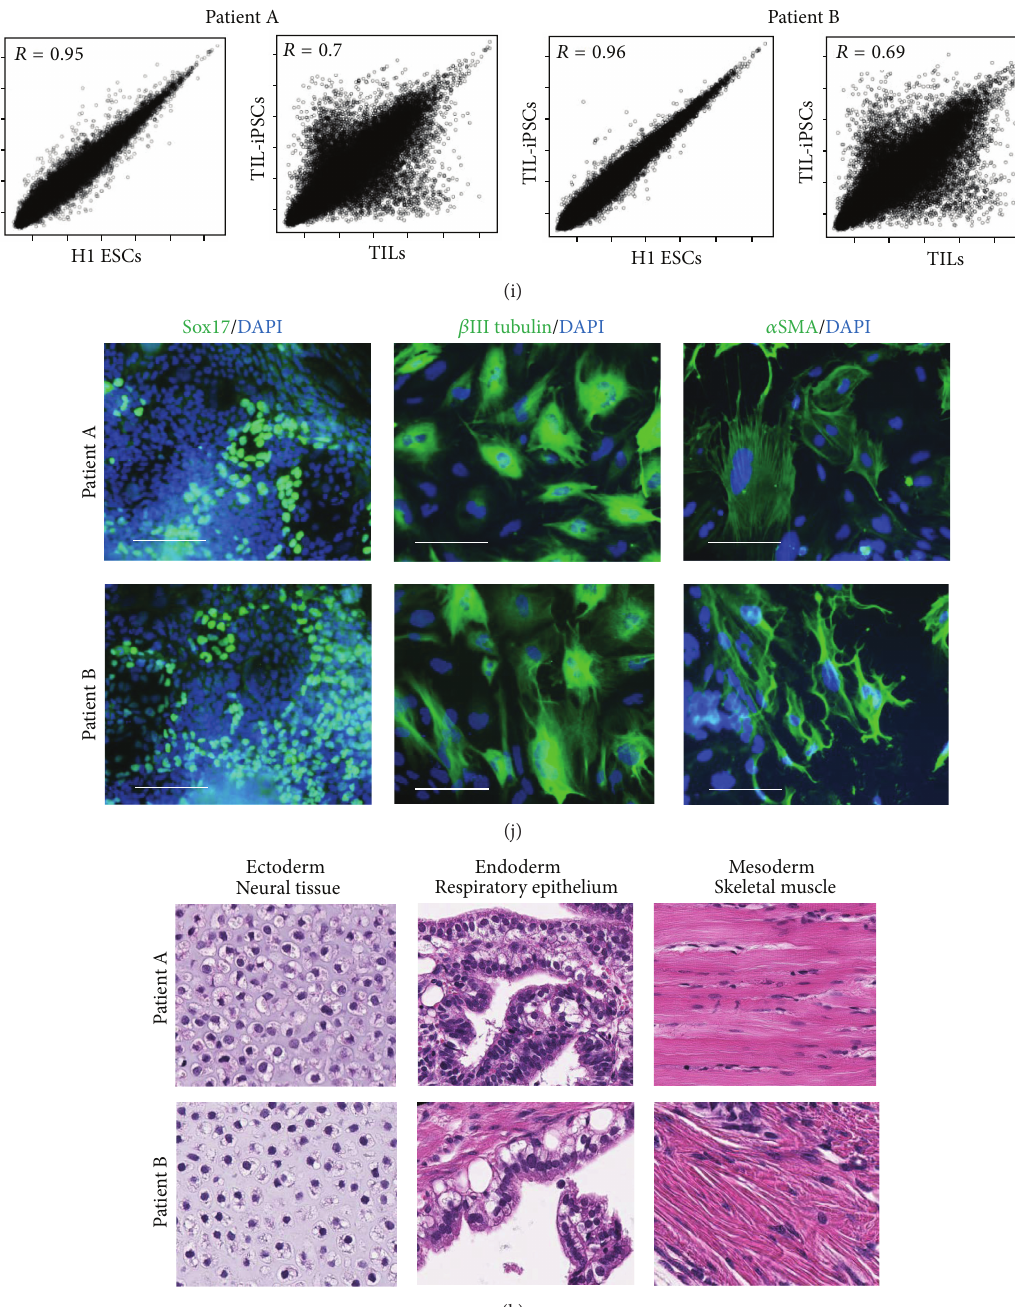
Figure 2: Generation of iPSCs from melanoma tumor-infiltrating lymphocytes. (a) Time schedule outlining expansion, activation, and reprogramming of TILs to generate iPSCs. (b) Morphologies of TILs when they started to expand 2-3 weeks after initiation of culture. (c) Efficient GFP introduction by Sendai virus (SeV) in TILs transfected at a MOI of 20. (d) Typical ESC-like iPSC colonies on day 21 after SeV infection. (e) Examples of 6-well plate containing SeV-reprogrammed iPSC clones stained for alkaline phosphatase (ALP), showing numerous ALP-positive colonies. (f) Cytogenetic analysis was performed on twenty G-banded metaphase cells from one of TIL-derived iPSCs (TIL- iPSCs). All twenty cells demonstrated a normal karyotype. (g) Immunofluorescence staining for pluripotency and surface markers (SSEA3, SSEA4, TRA-1-81, TRA-1-60, and OCT3/4) in iPSCs derived from melanoma TILs. Scale bars represent 100 𝜇 m. (h) RT-PCR analysis for the human ES cell marker genes NANOG , OCT3/4 , SOX2 , KLF4 , and c-MYC in TIL-iPSCs and ESCs (H1). (i) Scatter plots comparing the global gene expression profiles of TIL-iPSCs and ESCs and TIL-iPSCs and TILs. (j) Immunofluorescence staining for SOX17 (endodermal marker), 𝛽 III tubulin (ectodermal marker), and 𝛼 SMA (mesodermal marker) in TIL-iPSC-derived differentiated cell. Nuclei were counterstained with DAPI. Scale bars represent 100 𝜇 m. (k) Hematoxylin and eosin-stained representative teratoma sections of TIL-iPSC clones from patients (A) and (B) (6 weeks after injection into NOD/SCID